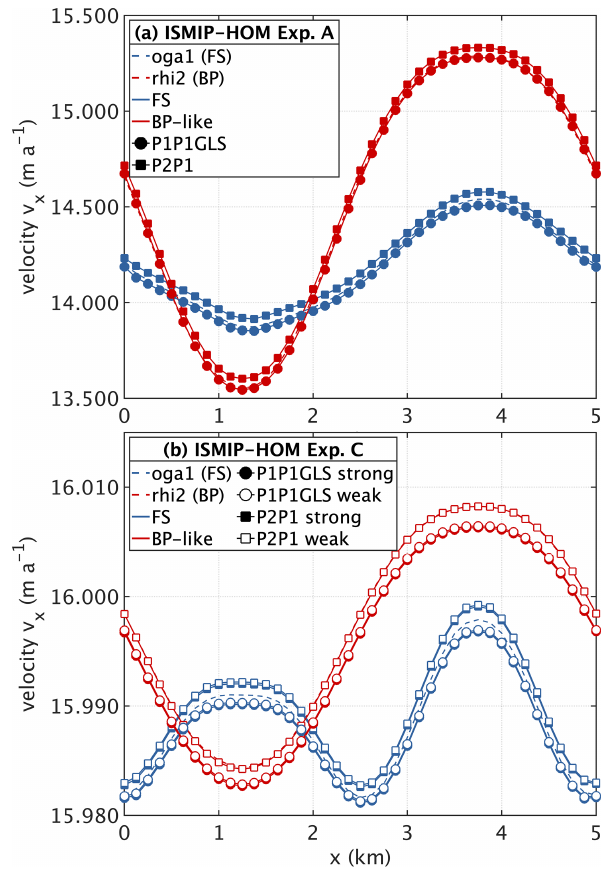
Figure 1. Results of the ISMIP-HOM experiments A (a) and C (b) for the length scale L = 5km. Surface velocity component v x (ma − 1 ) at y = L/ 4. Values computed in this study for FS and BP- like are compared to the BP model “rhi2” and the FS model “oga1” from the original ISMIP-HOM benchmark (Pattyn et al., 2008). Please note that the BP-like P1P1GLS and “rhi2” BP solutions in Experiment A overlap on each other; in Experiment C the “rhi2” BP solution is overlaid by BP-like P2P1 strong and BP-like P2P1